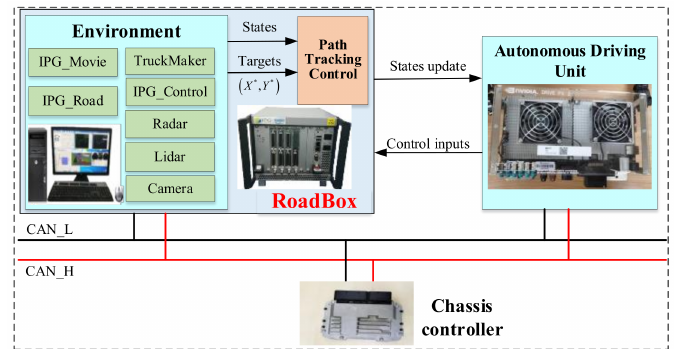
Figure 5. Hardware-in-the-loop simulation platform.